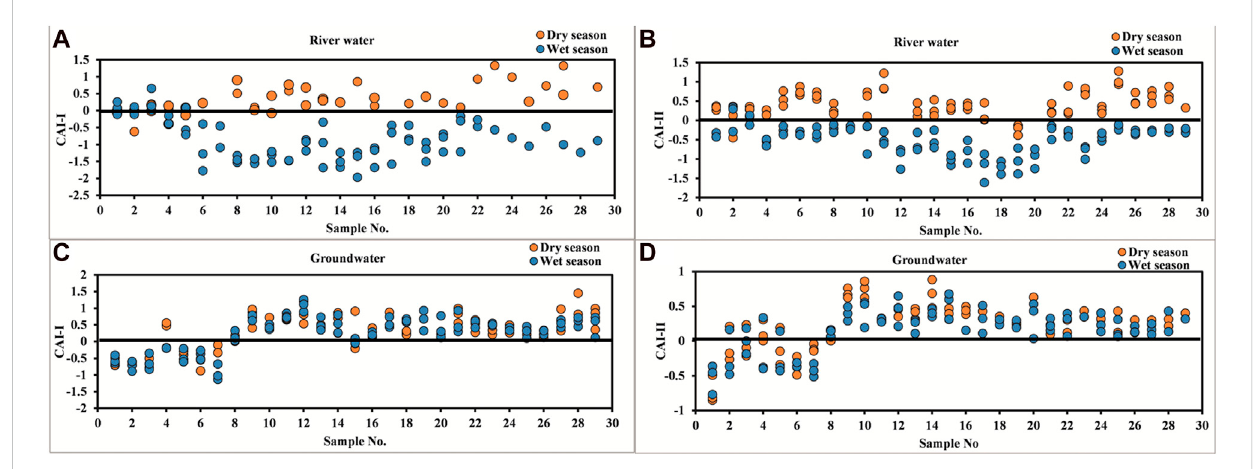
FIGURE 12 Chloro-alkaline indices I in (A) river water and (C) groundwater and chloro-alkaline indices II in (B) river water and (D) groundwater.